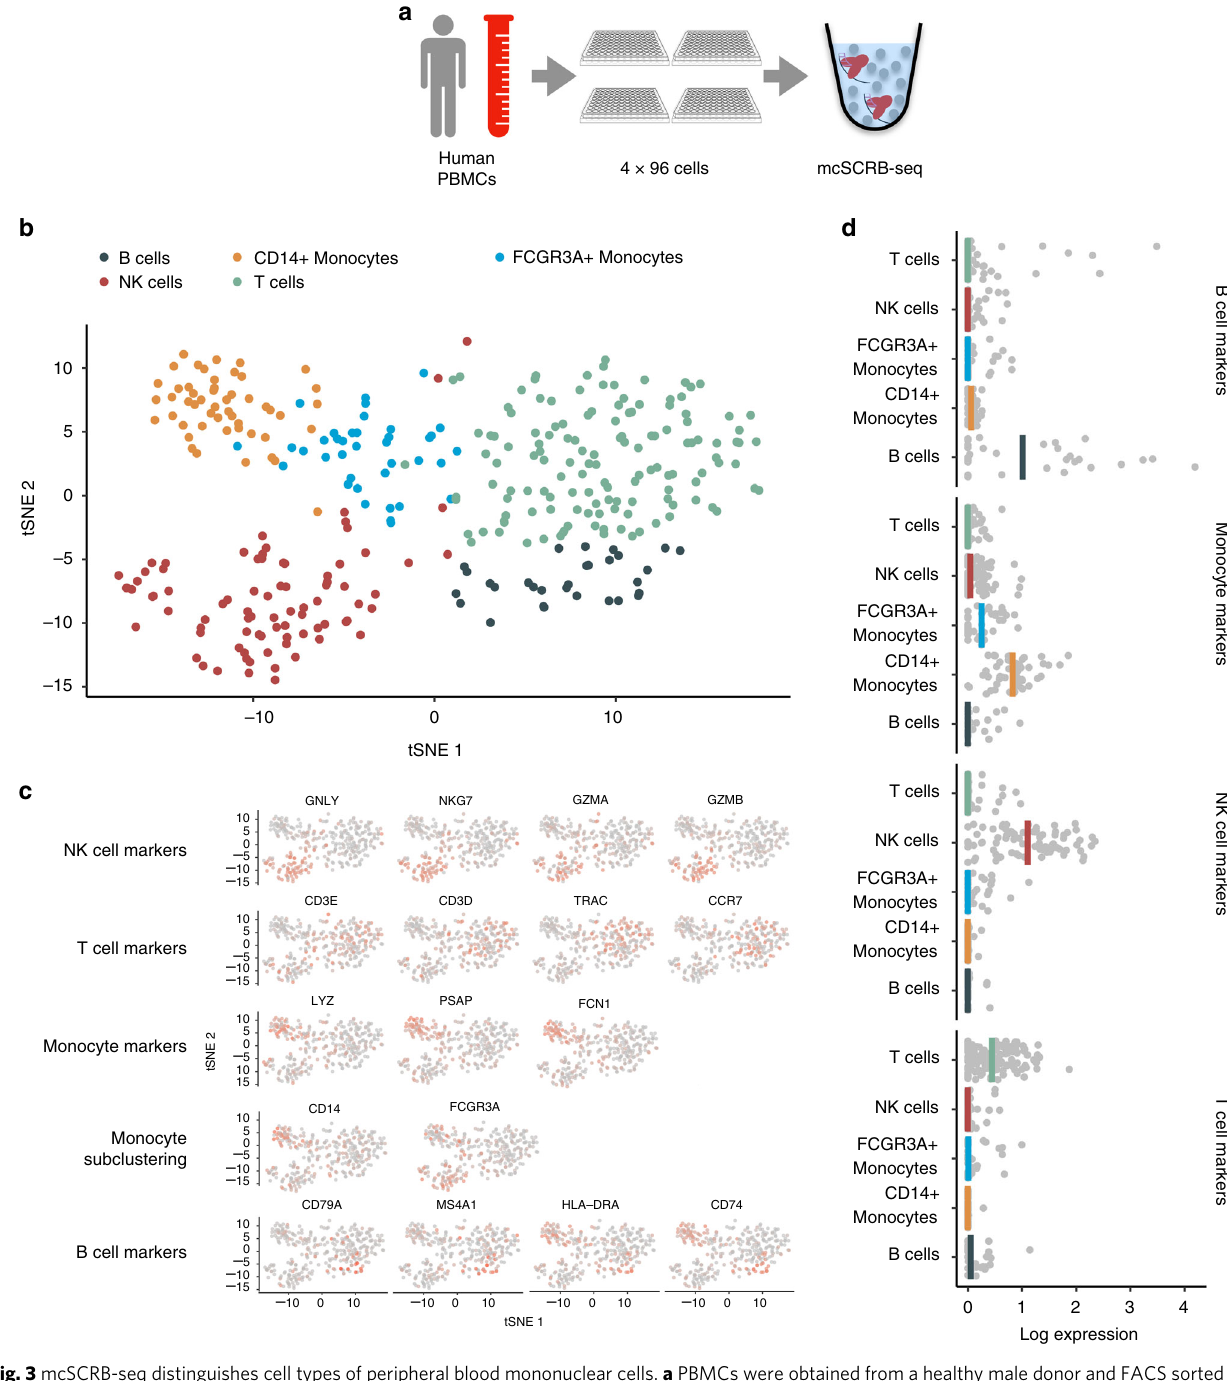
Fig. 3 mcSCRB-seq distinguishes cell types of peripheral blood mononuclear cells. a PBMCs were obtained from a healthy male donor and FACS sorted into four 96-well plates. Using the mcSCRB-seq protocol, sequencing libraries were generated. b tSNE projection of PBMC cells ( n = 349) that were grouped into fi ve clusters using the Seurat package 24 . Colors denote cluster identity. c tSNE projection of PBMC cells ( n = 349) where each cell is colored according to its expression level of various marker genes for the indicated cell types. Expression levels were log-normalized using the Seurat package. d Marker gene expression from c was summarized as the mean log-normalized expression level per cell. B-cell markers: CD79A , CD74 , MS4A1 , HLA-DRA ;